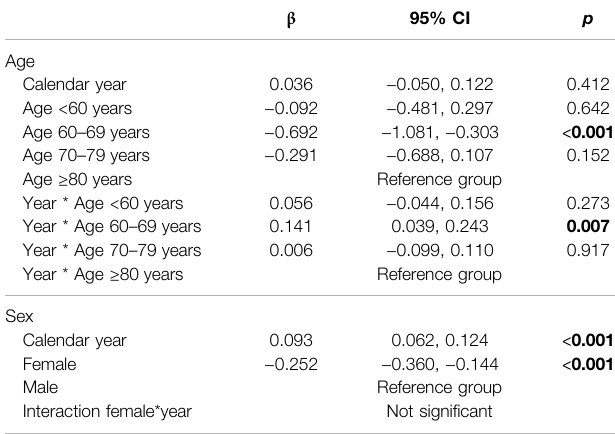
TABLE 2 | In fl uence of age and sex on glycosylated hemoglobin A1c thresholds. TABLE 3 | Characteristics of included patients in the systolic blood pressure (BP)